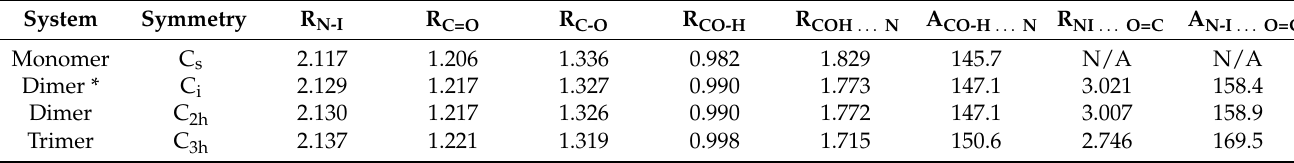
Table 1. Relevant geometrical parameters for the model system, ((HOOC) 2 -C 6 H 2 -(NHI) 2 ), and its cyclic dimer and trimer complexes. Bond lengths or distances, R, in angstroms, and angles, A, in